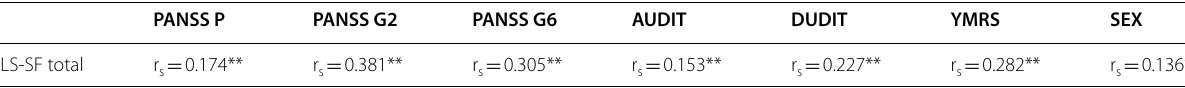
Table 1 Bivariate correlation